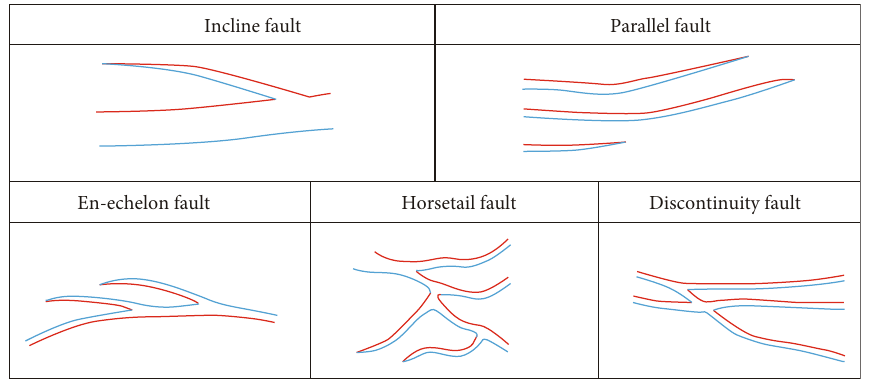
Figure 9: Five types of plane combination structure in Zhuangnan fault